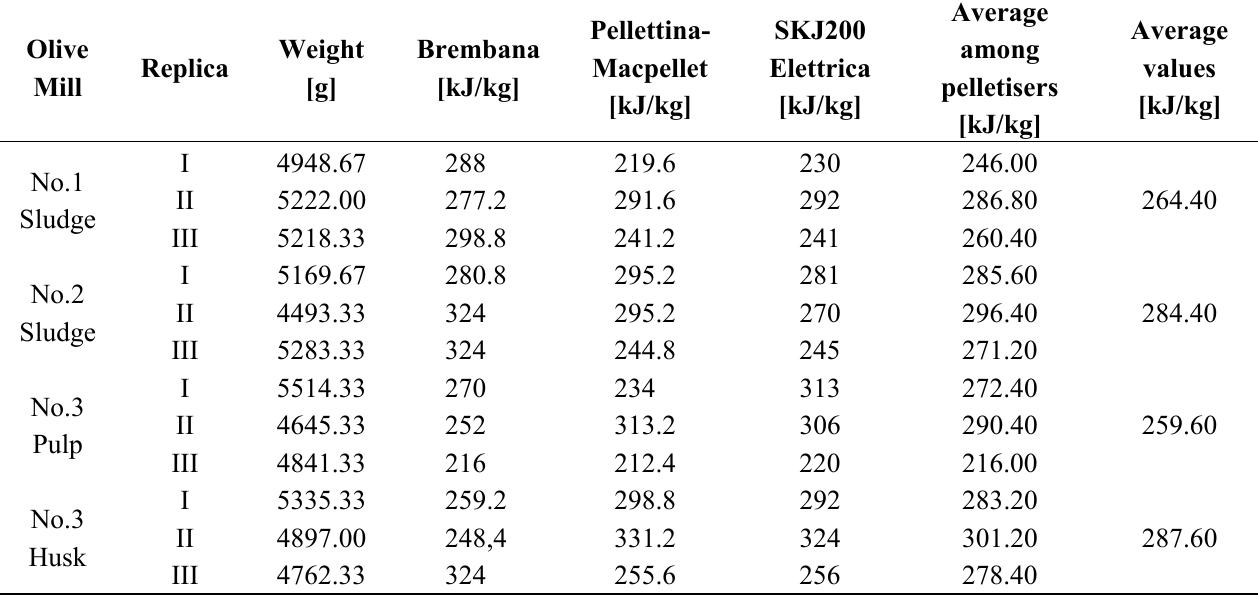
Table 4. Energy consumption for pelletisation of